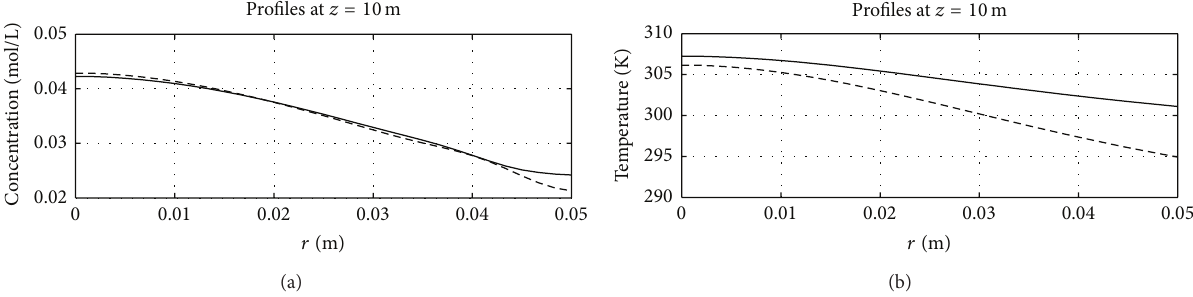
Figure 15: Steady state temperature and concentration profiles for Test 2 at 𝑧 = 10 m. Solid line—MPC. Dashed line—nominal profile